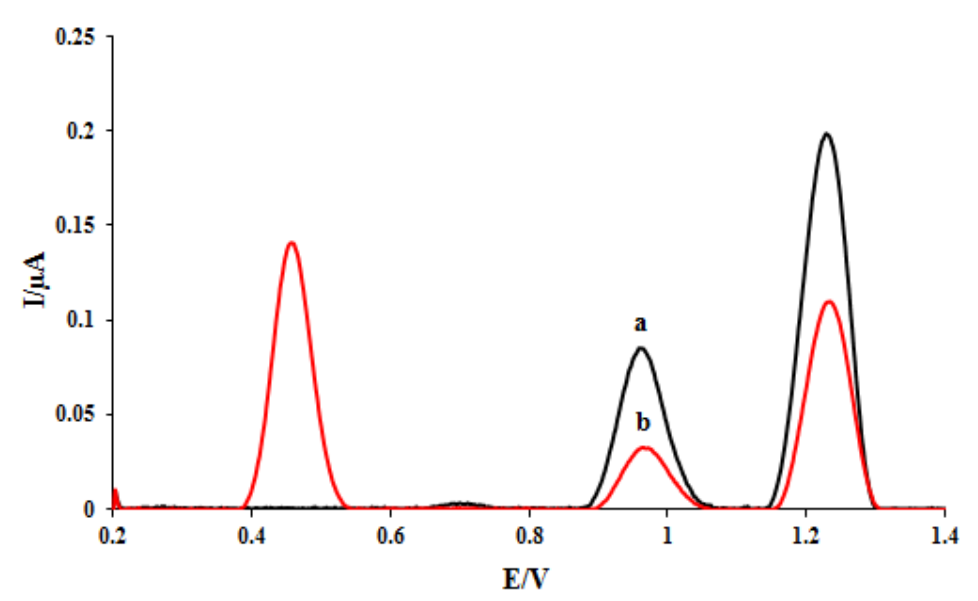
Figure 2. DPVs of DNA/rGO/GCE in the absence (a) and the presence of 3 mg L − 1 ELT (b). One of the essential and crucial parameters is the interaction time studies for drug- DNA binding. Therefore, using differential pulse voltammetry in the presence of 2 mg/L of the ELT, various interaction times were investigated in the range of 15–600 s (Figure 3). As seen in Figure 3, the oxidation peak currents of dGuo and dAdo were decreased with the increase of interaction times. The shifting of the peak potential of dGuo in a positive direction shows that the drug may be interacting with dsDNA via the intercalation mode. The plot of peak currents of dGuo (blue dots) and dAdo (red dots) versus interaction times was shown in Figure 4. At 5.0 min, selected as the optimum interaction time, the signal of dGuo and dAdo showed the minimum standard error.